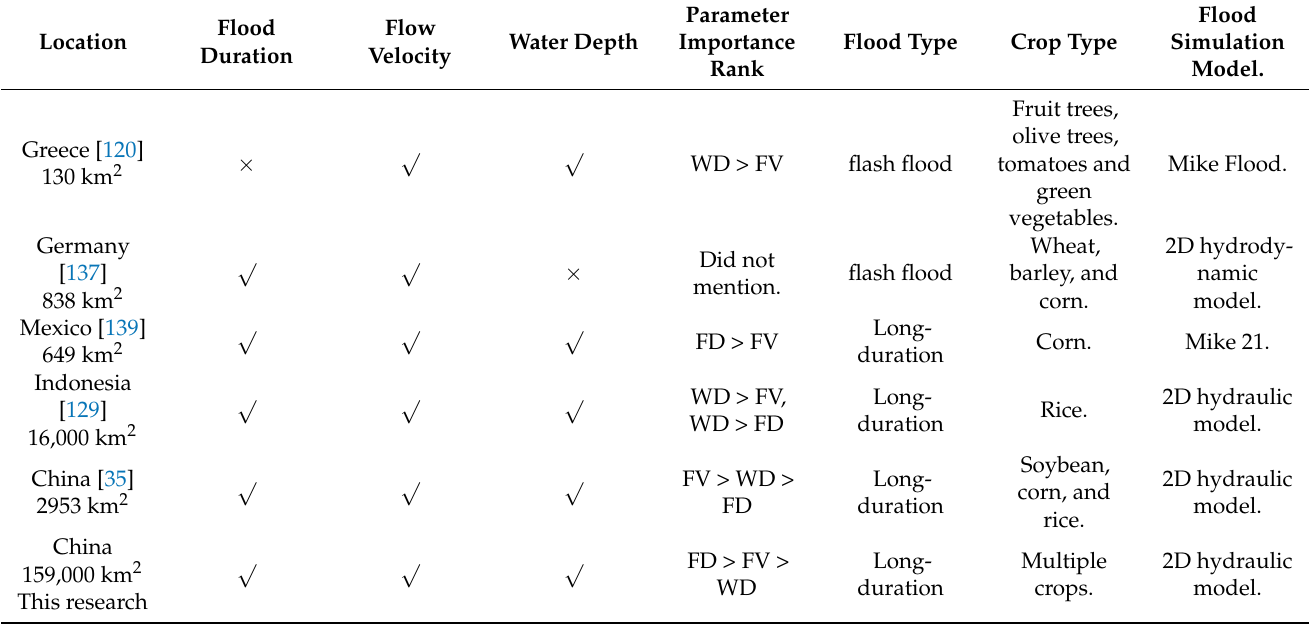
Table 2. The importance rank of Flood Duration (FD), Flow Velocity (FV), and Water Depth (WD) calculated by 2D hydraulic models in crop yield loss related